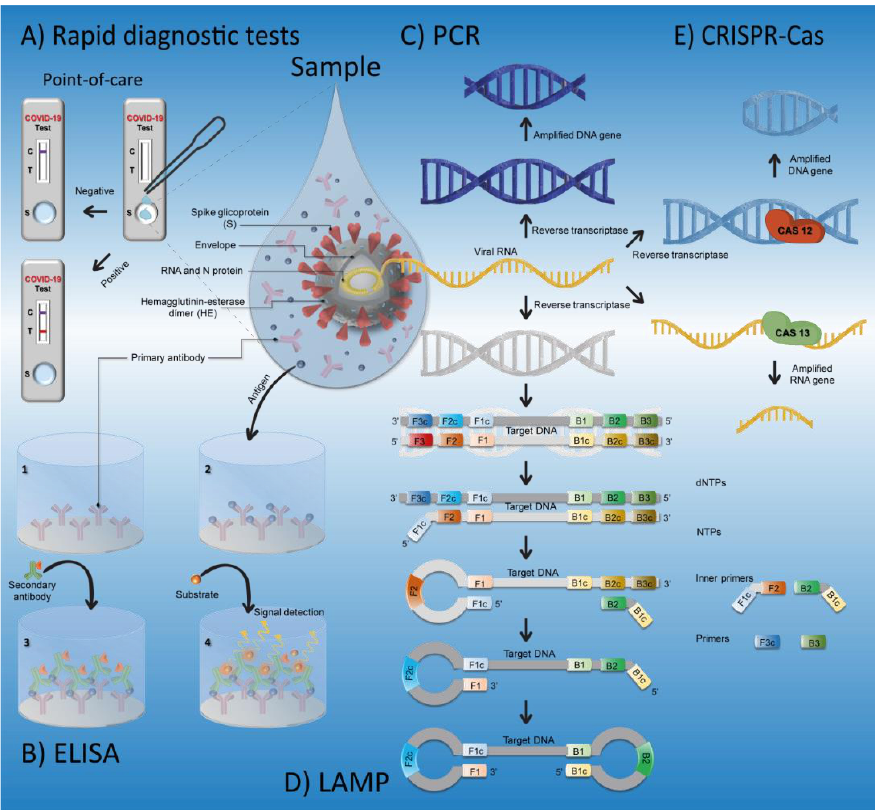
Figure 1. Schematic representation of the different detection technologies available and the sample under analysis: ( A ) Rapid Diagnostic Tests, ( B ) ELISA, ( C ) PCR, ( D ) LAMP, ( E ) CRISPR – Cas. LFIA also uses N and S proteins to detect a SARS-CoV-2 immune response. After